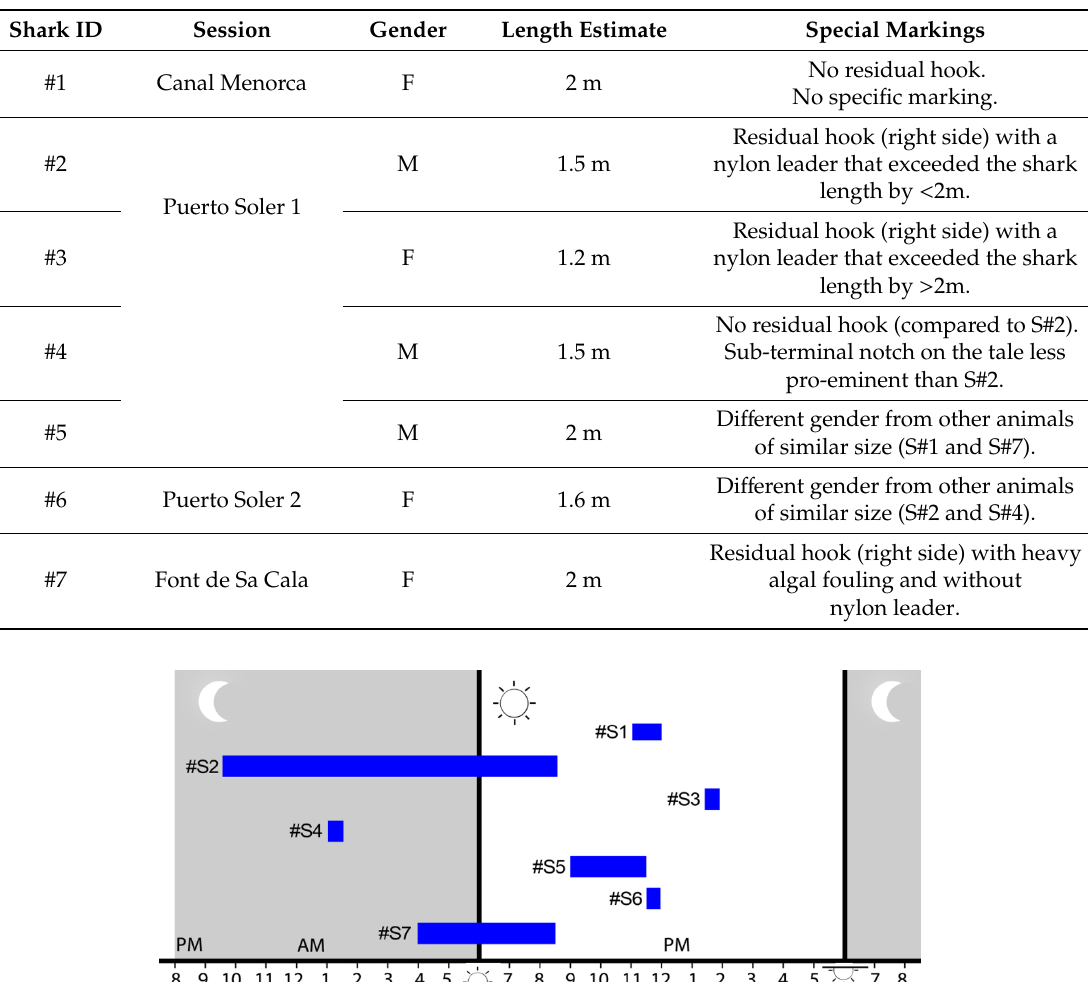
Table 2. Description of the sharks with discriminating parameters.